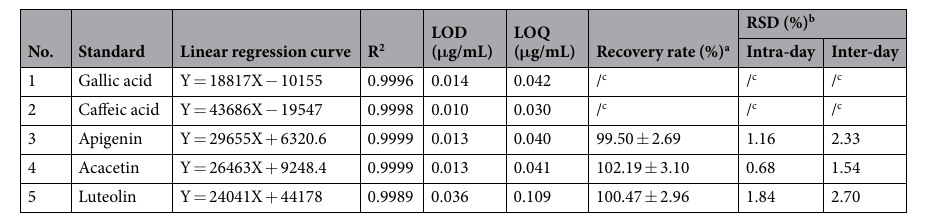
Table 4. Results for method validation. a Recovery rate (%) = [(measured amount after spiking − measured amount before spiking)/actual amount spiked] * 100. b RSD (%) = (SD/Mean) * 100, where RSD means relative standard deviation and SD means standard deviation. c Not